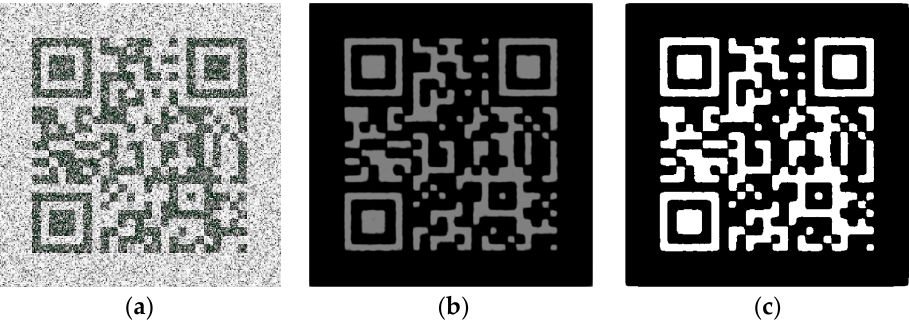
Figure 4. ( a ) is the same image as figure 3a; ( b ) is prediction result of UNet branch; ( c ) is the binarization image of the image in ( b ).